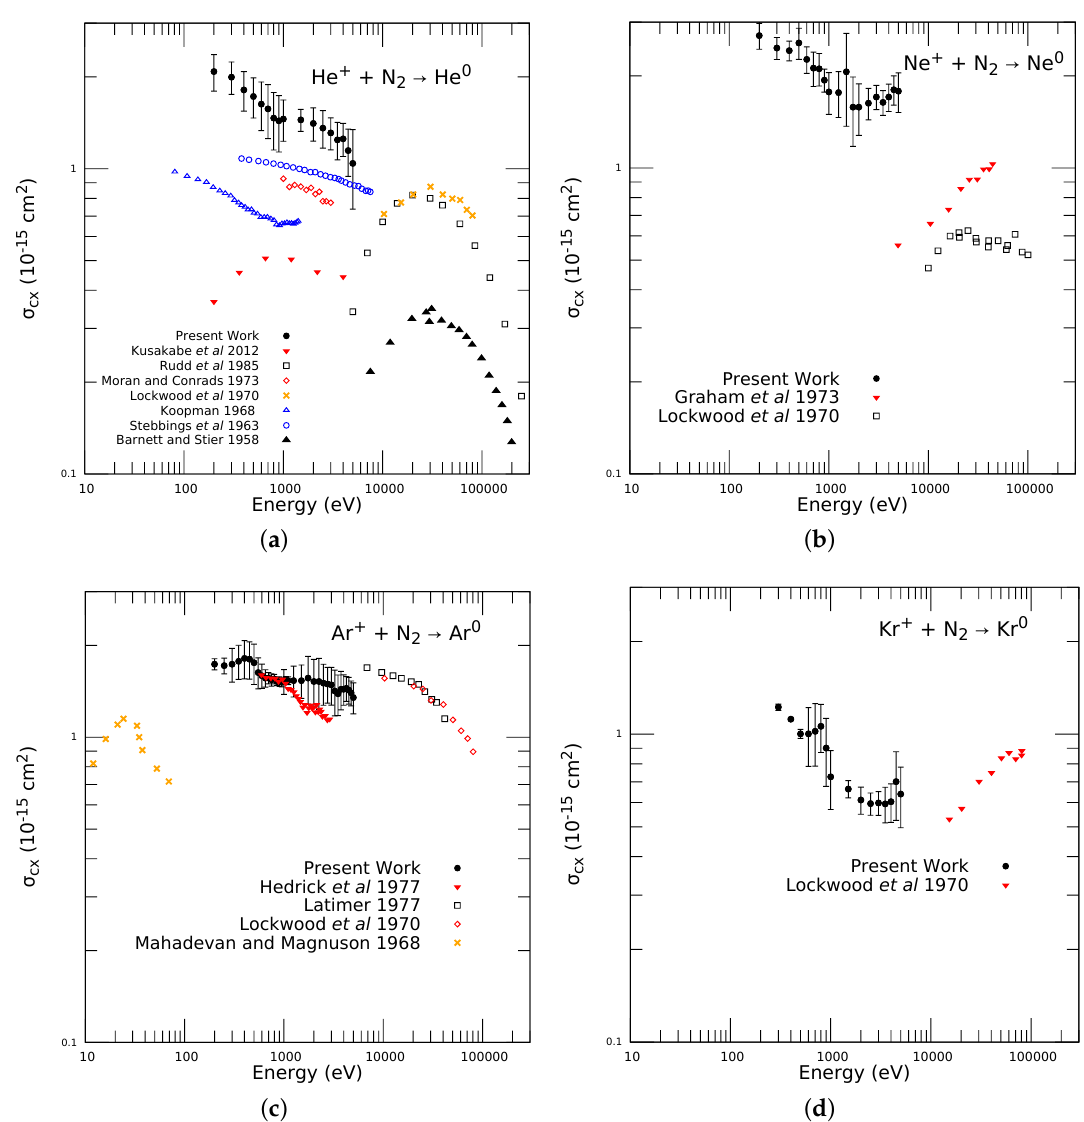
Figure 2. Total charge exchange cross sections for A + + N 2 → A for A = (He, Ne, Ar, Kr). The error bars shown represent statistical uncertainty in the measurements. ( a ) Total charge exchange cross sections for He + and N 2 . The measurements shown: full circles (present work, manipulator-mounted gas cell (MGC)), inverted triangles [11], hollow squares [16], diamonds [17], × [18], hollow triangles [19], open circles [20], triangles [21]. ( b ) Total charge exchange cross sections for Ne + and N 2 . The measurements shown: black circles (present work, MGC), inverted triangles [23], squares [18]. ( c ) Total charge exchange cross sections for Ar + and N 2 . The measurements shown: black circles (present work, MGC), inverted triangles [24], squares [25], diamonds [18], × [26]. ( d ) Total charge exchange cross sections for Kr + and N 2 . The measurements shown: black circles (present work, MGC), inverted triangles